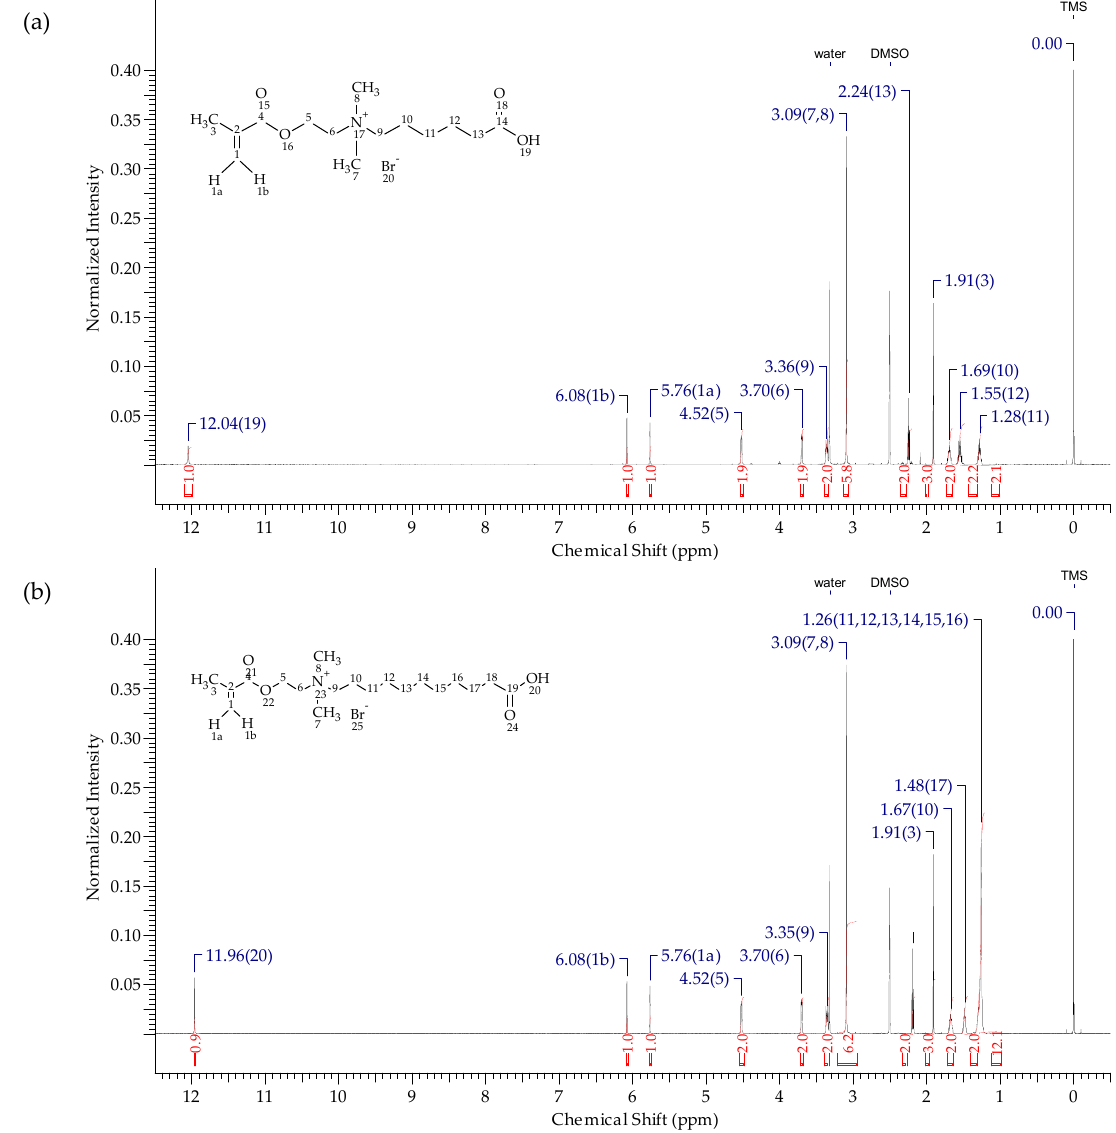
Figure 1. 1 H-NMR spectra of AMadh1 ( a ) and AMadh2 ( b ) products.